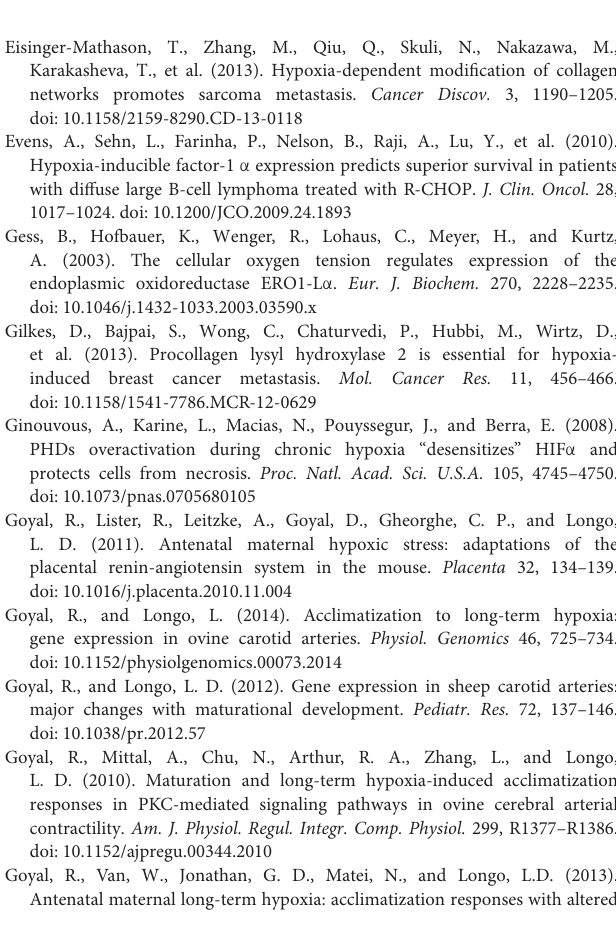
Supplementary Table 2 | Table lists the primers used in the present study. Supplementary Table 3 | Table lists the genes upregulated by hypoxia exposure. Supplementary Table 4 | Table lists the genes downregulated by hypoxia exposure. Supplementary Table 5 | Genes common to three studies analyzed to identify HIF-responsive genes. Supplementary Table 6 | Genes hypermethylated with chronic hypoxia